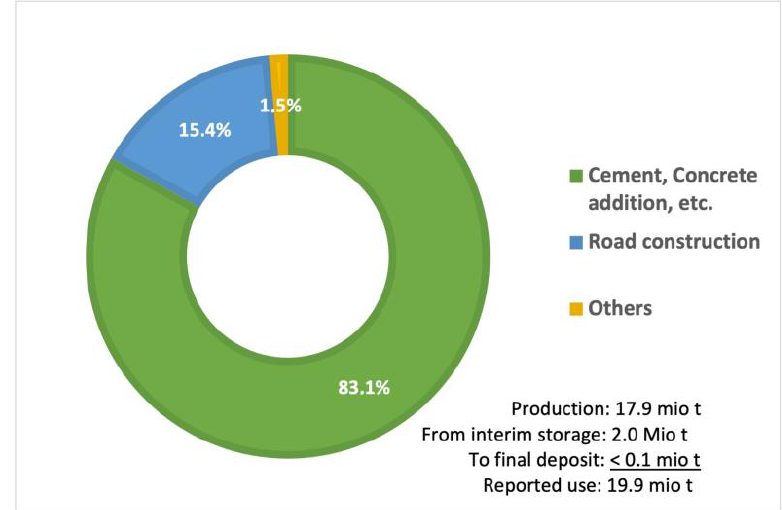
Figure 3. Use of BF slag in Europe in 2021 [4].